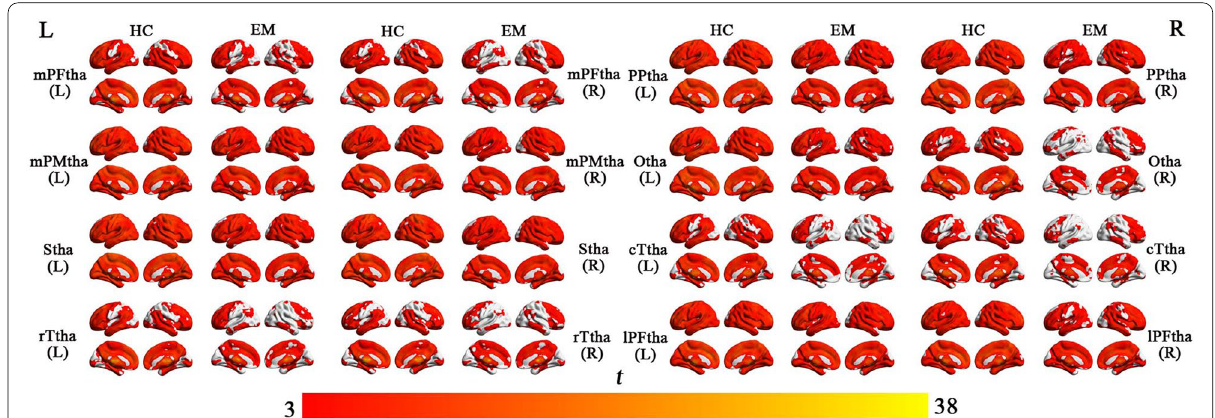
Fig. 2 The rsFC maps of the 16 thalamic subregions for both groups. Only the positive rsFC map of each subregion of the thalamus of each group is revealed ( P < 0.05, cluster-level FWE corrected). Abbreviations: EM, episodic migraine; HC, healthy control; mPFtha, medial prefrontal thalamus; mPMtha, premotor thalamus; Stha, sensory thalamus; rTtha, rostral temporal thalamus; PPtha, posterior parietal thalamus; Otha, occipital thalamus; cTtha, caudal temporal thalamus; lPFtha, lateral prefrontal thalamus; L, left; R,